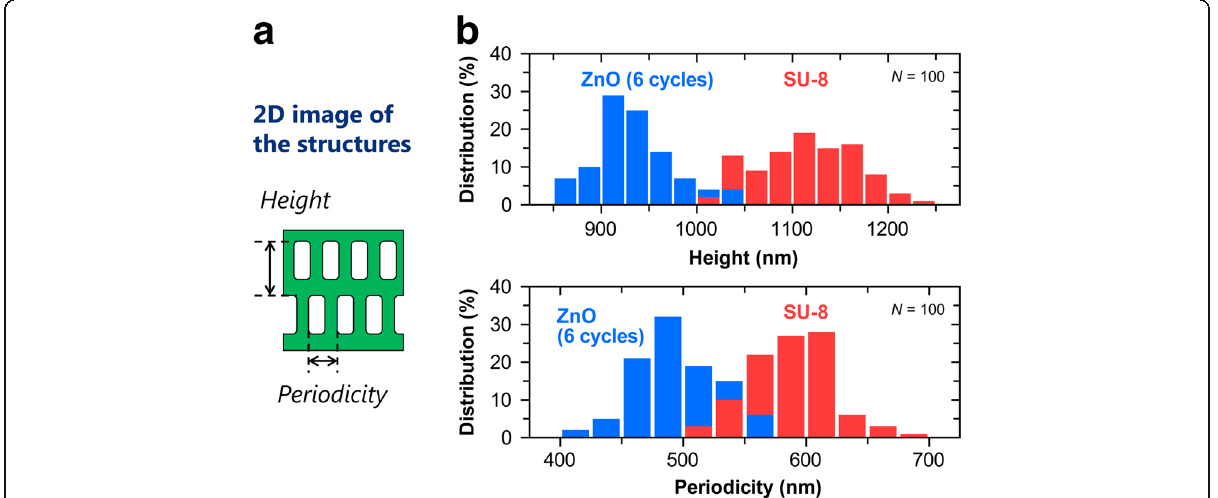
Fig. 6 2D image structure and histograms that represent the measured values of the structural sizes. a Schematic diagram of 2D structure height and periodicity in in-plane direction of the structures and ( b ) histograms that represent the measured values of the structural sizes for the tem- plate and the inverse structure for ZnO and